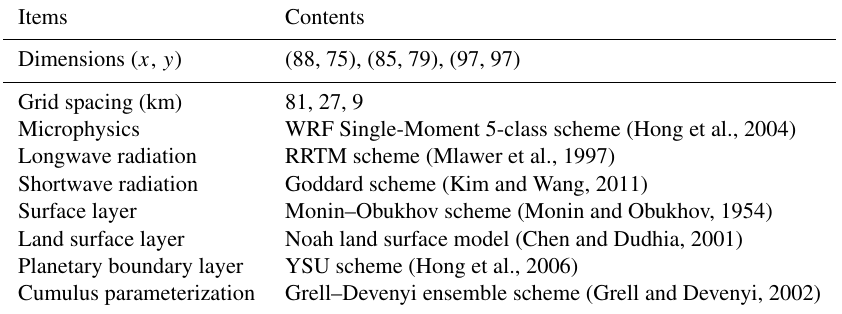
Table 2. The domains and physical options for WRF in this